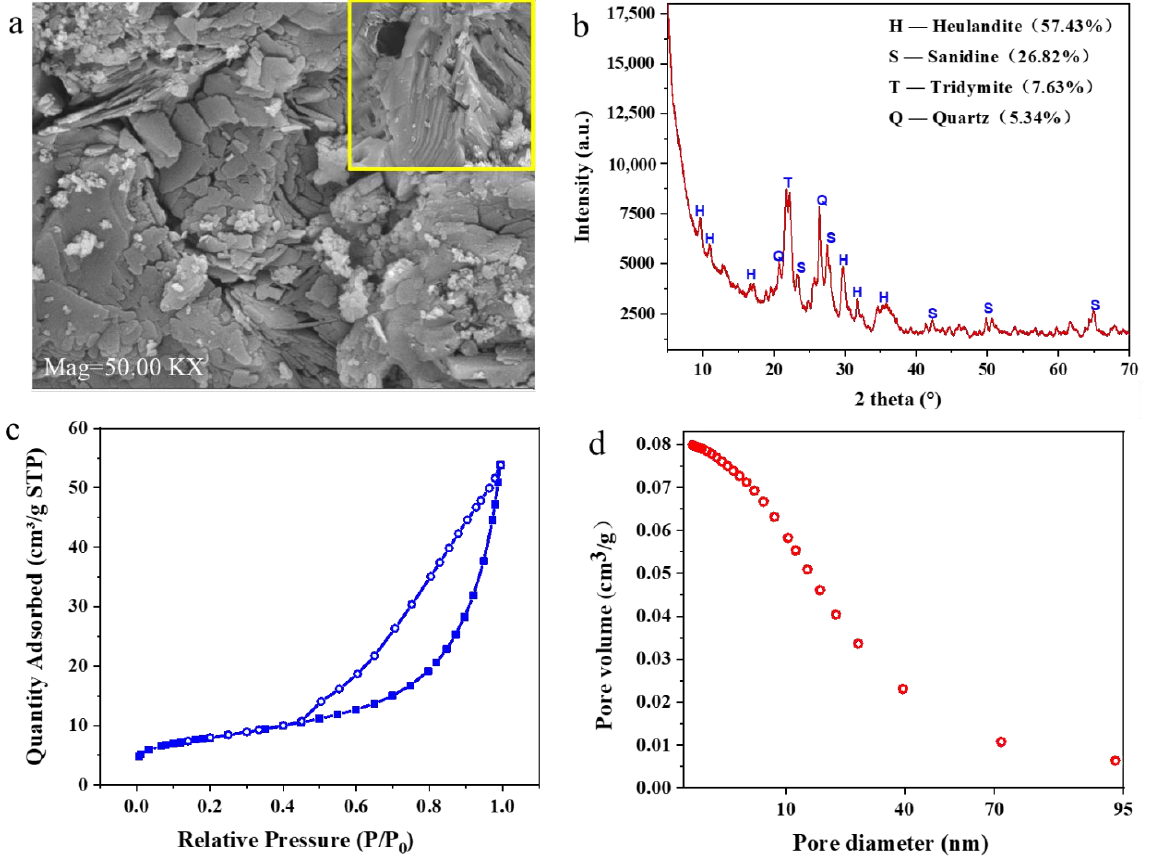
Figure 1. The basic properties of the natural zeolite. ( a ) SEM images; ( b ) XRD patterns; ( c ) N 2 ad- Table 1. Physical properties of the Chinese natural zeolite in comparison with other zeolites.